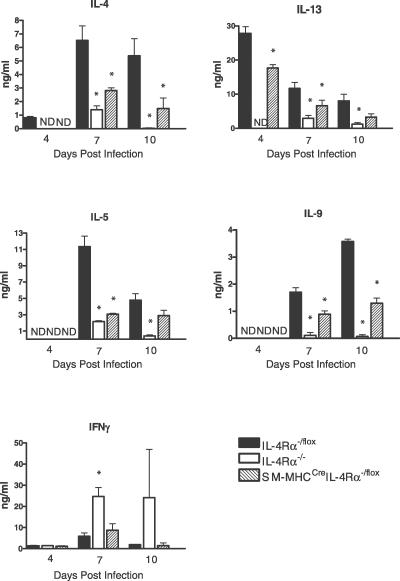
CD4+ Lymphocytes Are Essential for N. brasiliensis ClearanceMLNs were removed from infected mice on days 4, 7, and 10 PI. CD4+ cells were isolated and stimulated with CD3 for 72 h. Supernatants were then analyzed for cytokine production by ELISA as described in Materials and Methods. *Significant difference (p < 0.05) from IL-4Rα−/lox mice. Data are representative of four repeated experiments.